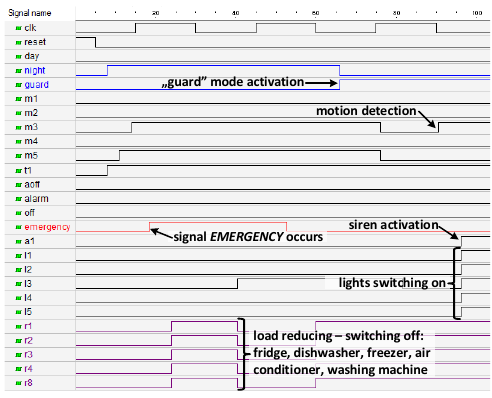
Figure 16. SHS—simulation results.